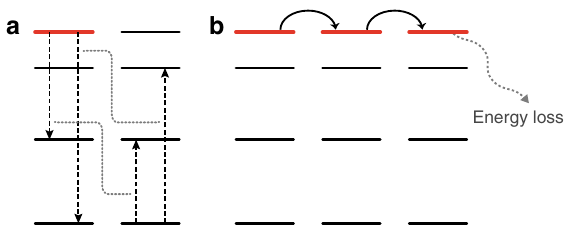
Fig. 1 General processes of dopant interactions responsible for depopulation of an excited state. a Cross-relaxation and phonon-assisted energy transfer that depopulates an excited state locally. To counteract the depopulation associated with the localized energy exchange interaction, a high excitation power is needed to enhance the excitation process. b Long- distance energy migration through the dopant sublattice that takes the energy to lattice or surface defects. The energy migration-induced depopulation can be alleviated by spatially con fi ning the excitation